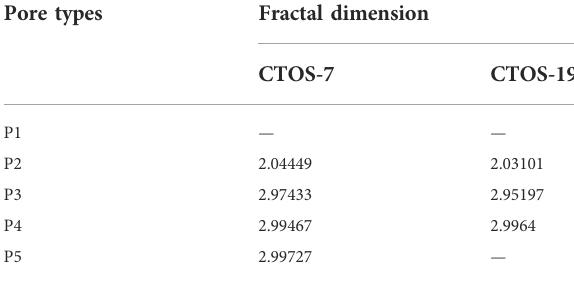
TABLE 3 The fractal dimensions of various type of pore in CTOS-7 and CTOS-19 samples. Pore types Fractal dimension CTOS-7